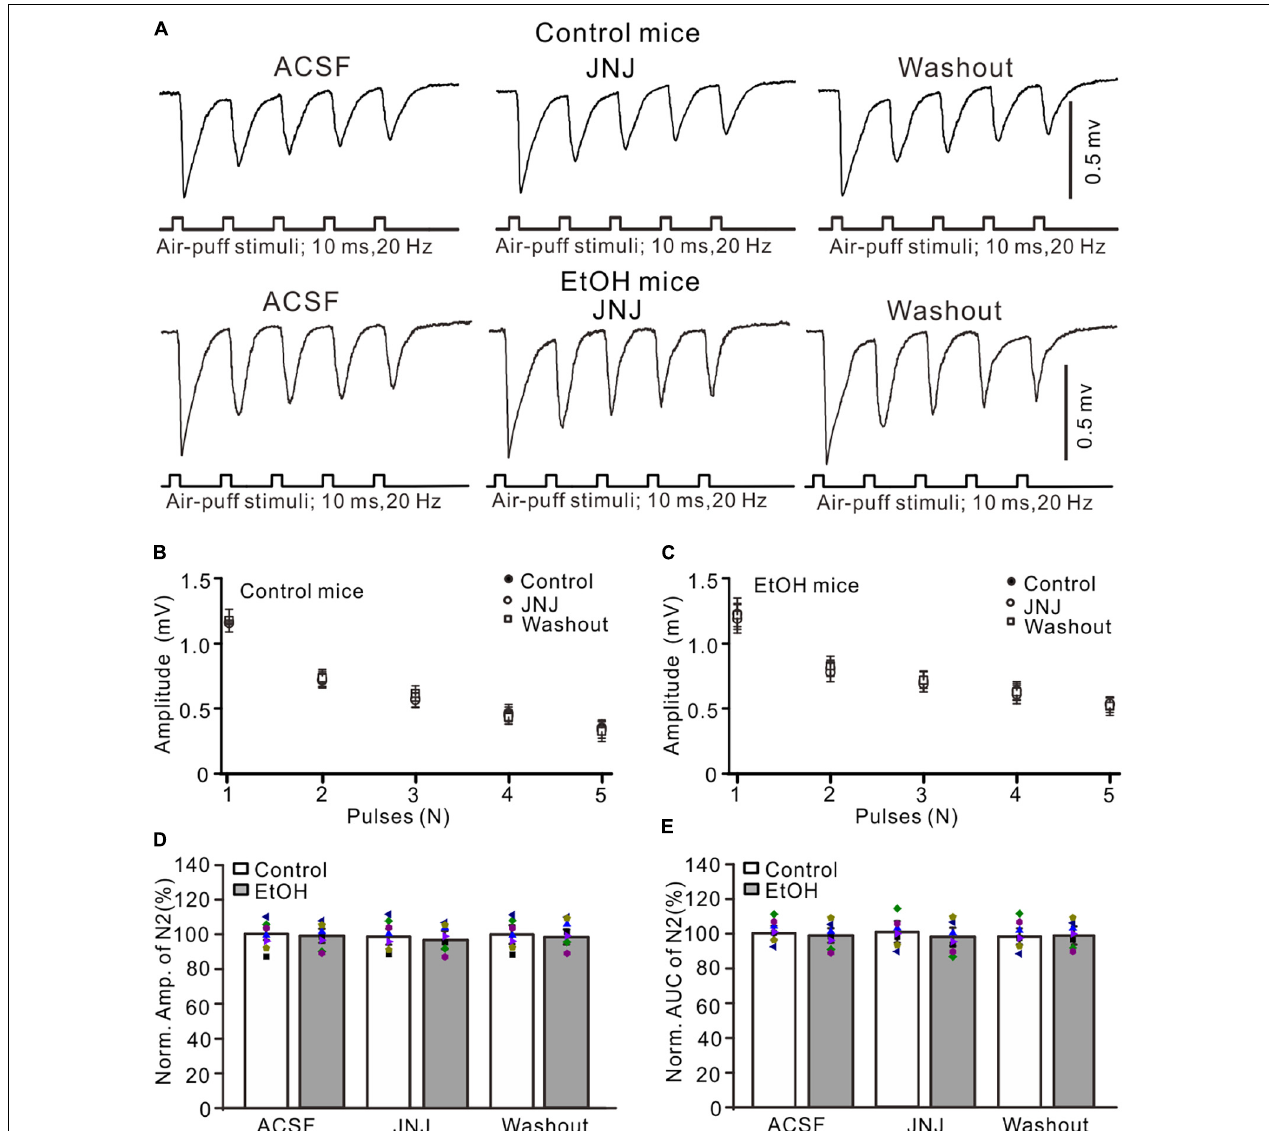
FIGURE 5 | Blockade of mGluR1 failed to prevent the ethanol exposure-induced enhancement of facial stimulation-evoked MF–GC synaptic transmission. (A) Representative field potential traces showing that the air-puff stimuli (10 ms, 60 psi; 5 pulse, 20 Hz) on the ipsilateral whisker pad evoked field potential responses, recorded from the GL of control and ethanol-exposed mice in treatments of ACSF, JNJ (10 µ M), and recovery (washout). (B) Summary of data showing the absolute amplitudes of N1–N5 in treatments with ACSF, JNJ, and recovery (washout) in control mice. (C) Pooled data showing the absolute values of N1–N5 in treatments with ACSF, JNJ, and recovery (washout) in ethanol-exposed mice. (D) A bar graph with individual data (Symbols of different colors) showing the normalized amplitude of N2 in treatments with ACSF, JNJ, and recovery (washout). (E) A bar graph with individual data (Symbols of different colors) showing the normalized AUC of N2 for each treatment. n = 7 in each